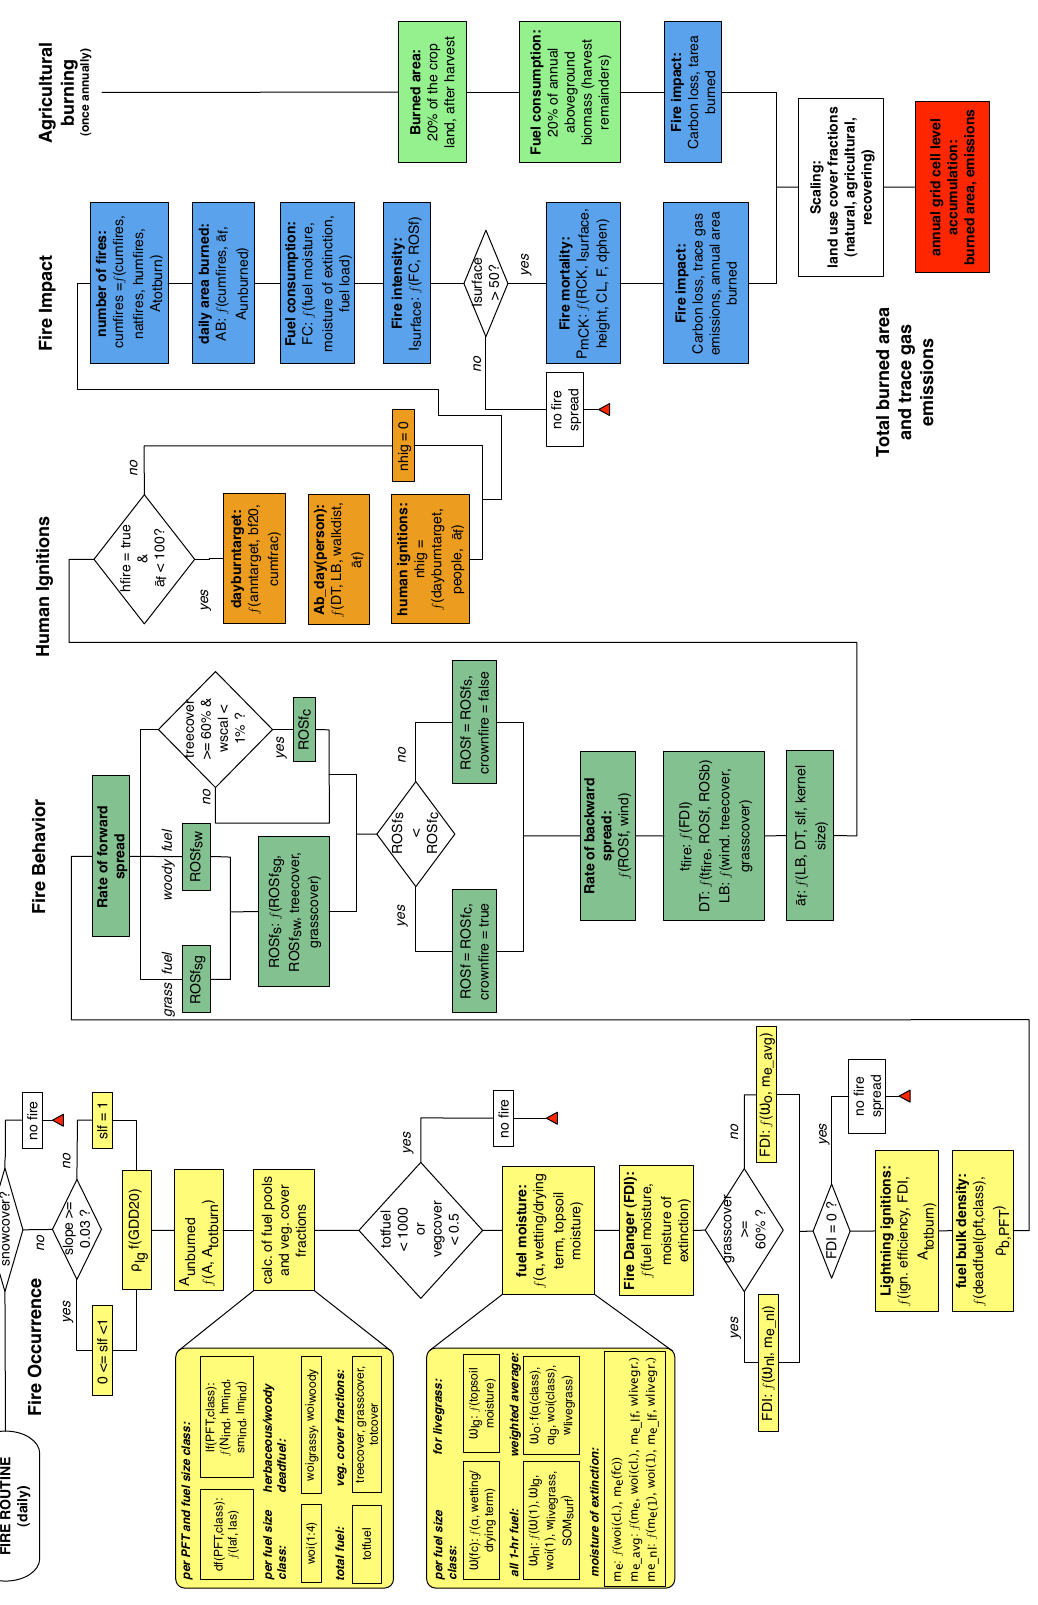
Fig. 1. Flowchart of